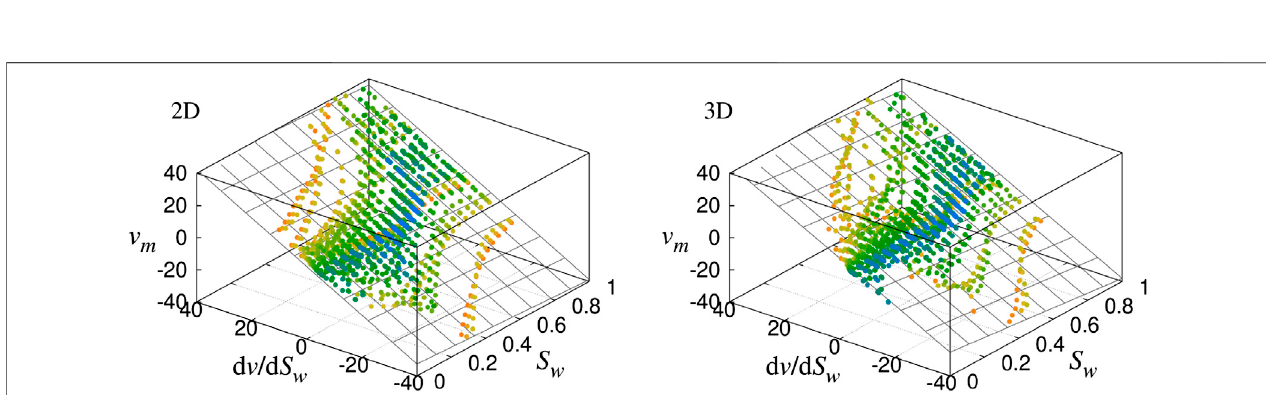
FIGURE 15 | Plot of the co-moving velocity v m as a function of S w and d v / d S w for the square (2D) and Berea (3D) networks. The data shows a rough planner behavior.